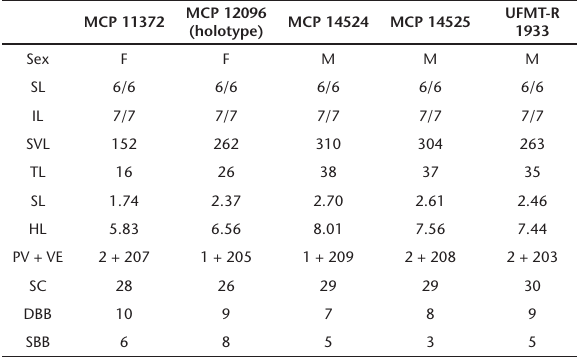
first preventral. Dorsal scales smooth in 15 rows at midbody. No apical pits. 205 ventrals. 26 paired subcaudals (tail complete). Anal scale divided. 4 + 2 maxillary teeth. Table 1. Variation in characters of the type series of Apostolepis kikoi sp. nov. Supralabials (SL), infralabials (IL), snout-vent length (SVL), tail length (TL), snout length (SL), head length (HL), preventrals (PV), ventrals (VE), subcaudals (SC), number of dorsal scales of black caudal band (DBB) and number of subcaudal scales of black caudal band (SBB). Measurements in